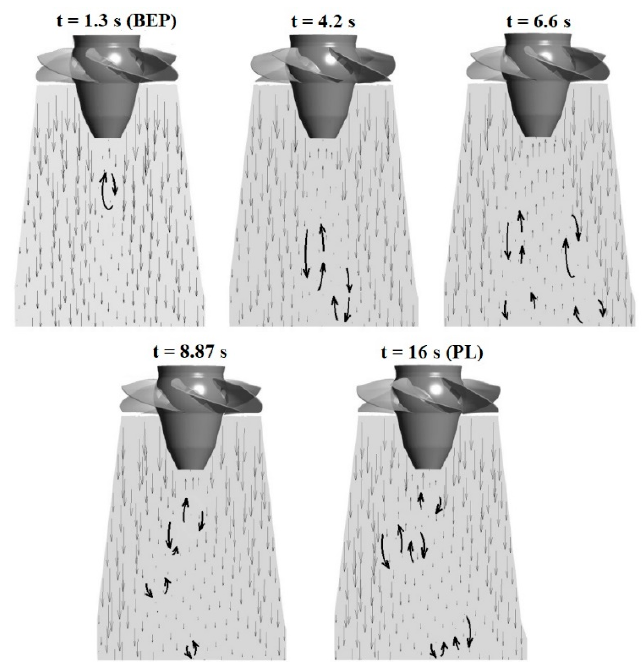
Figure 19. Axial projection of the velocity vector field during load rejection, t = 1.3 s at the BEP (the beginning of the transient operation), t = 4.2 s and t = 6.6 s (during the guide vane closure), t = 8.87 s (the end of the transient operation), t = 16 s at PL.